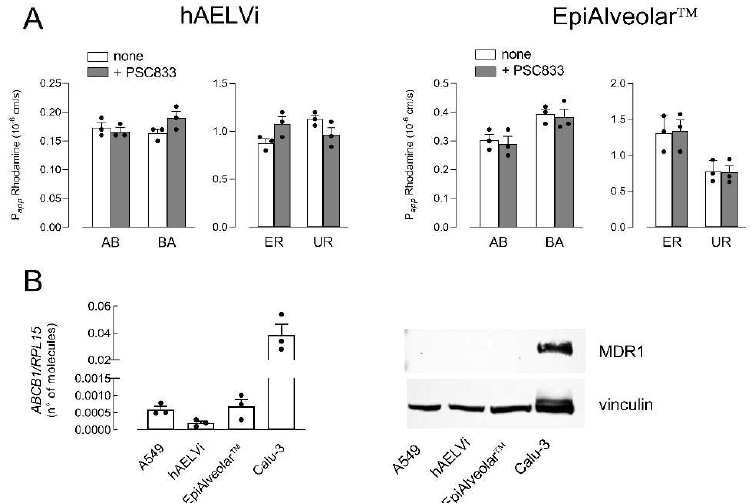
Figure 2. Expression and activity of MDR1. Panel ( A ): The apical-to-basolateral (AB) and basolateral- to-apical (BA) fluxes of 1 µ M Rhodamine123 were measured both in the absence (none) and in the presence of 10 µ M PSC833, as indicated. Data obtained were employed to calculate the efflux ratio (ER) and uptake ratio (UR), as defined in Materials and Methods. Bars are the mean ± SEM of 3 independent determinations (single dots). Panel ( B ): The expression of MDR1 gene and protein were performed with RT-qPCR and Western blot analyses, respectively, as described in Materials and Methods. Data of mRNA expression are the mean ± SEM of 3 independent determinations (single dots). A representative Western blot is shown that, repeated twice, gave comparable results.